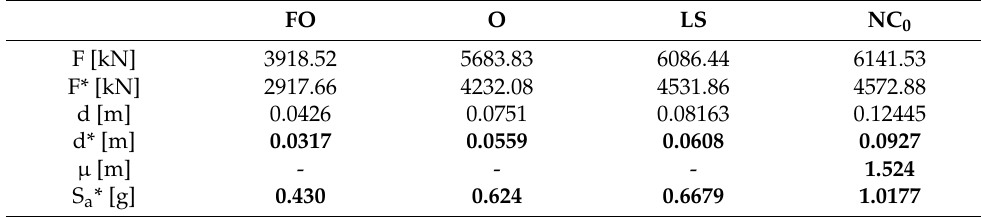
Table 5. Nassar and Krawinkler approach